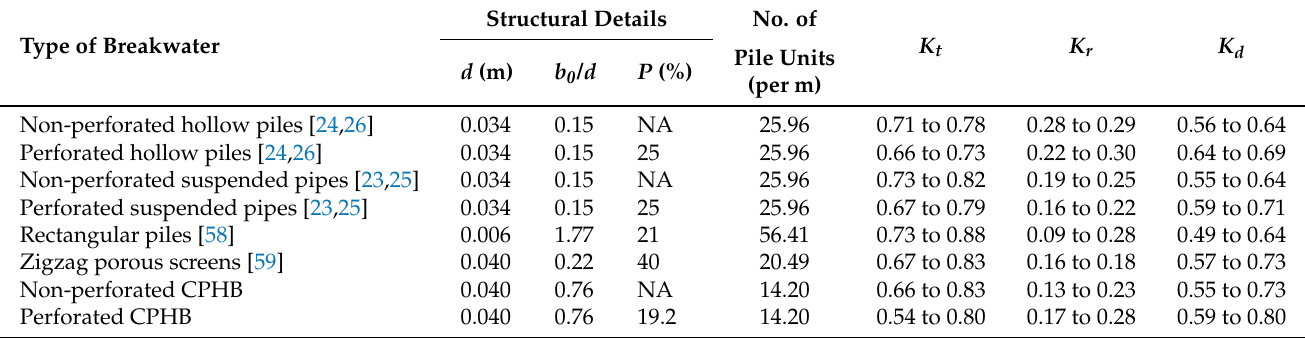
Table 5. Comparison of CPHB performance with other pile